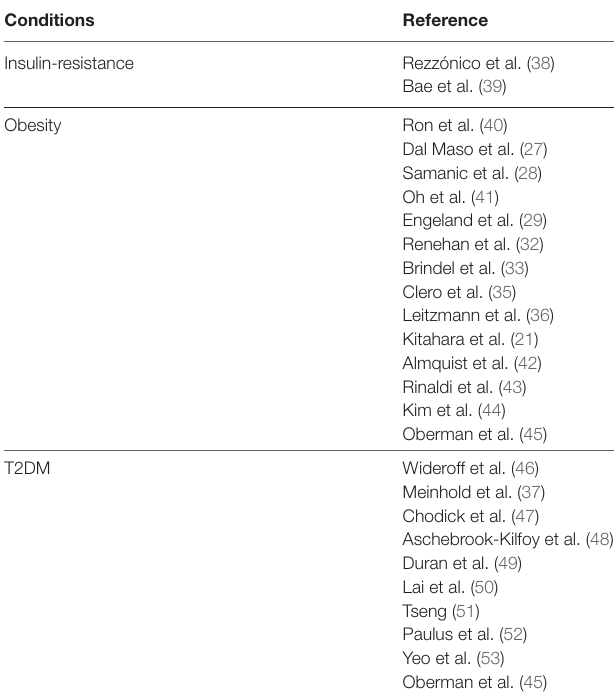
TAble 1 | Studies regarding a possible association between TC risk and insulin- resistance and related